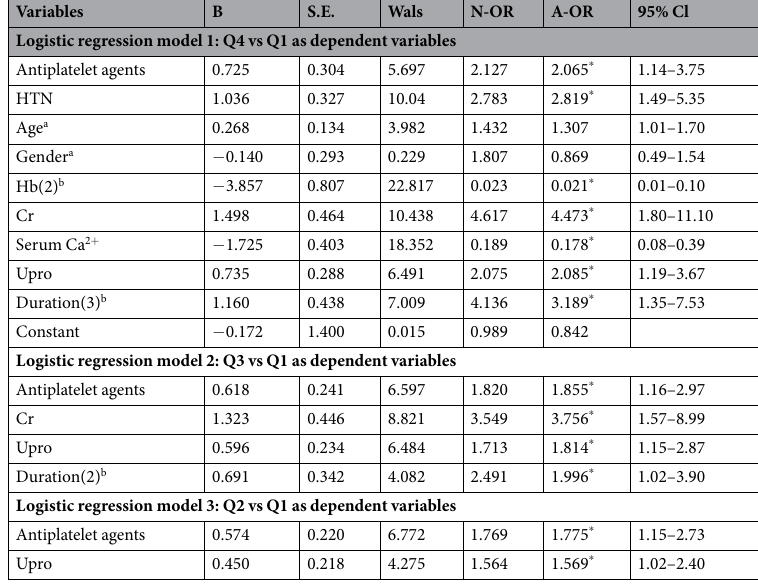
Table 4. Logistic regression model for RDW in T2D patients. Notes: a Age and gender were considered confounding factors that were adjusted for in the logistic model; b Dummy variables were set due to the characteristic of multi-classification in Hb and Duration; Hb (2) indicates a higher level of Hb ( ≥ 110 g/dL); Duration (2) indicates a duration of 3 to 9 years; Duration (3) indicates a duration ≥ 10 years; Wals, Wals’ χ 2 test; N-OR, Non-adjusted OR (Odds ratio) value; A-OR, Adjusted OR value; 95% Cl, 95% confidence interval of A-OR; * P < 0.05 for Wals’ χ 2